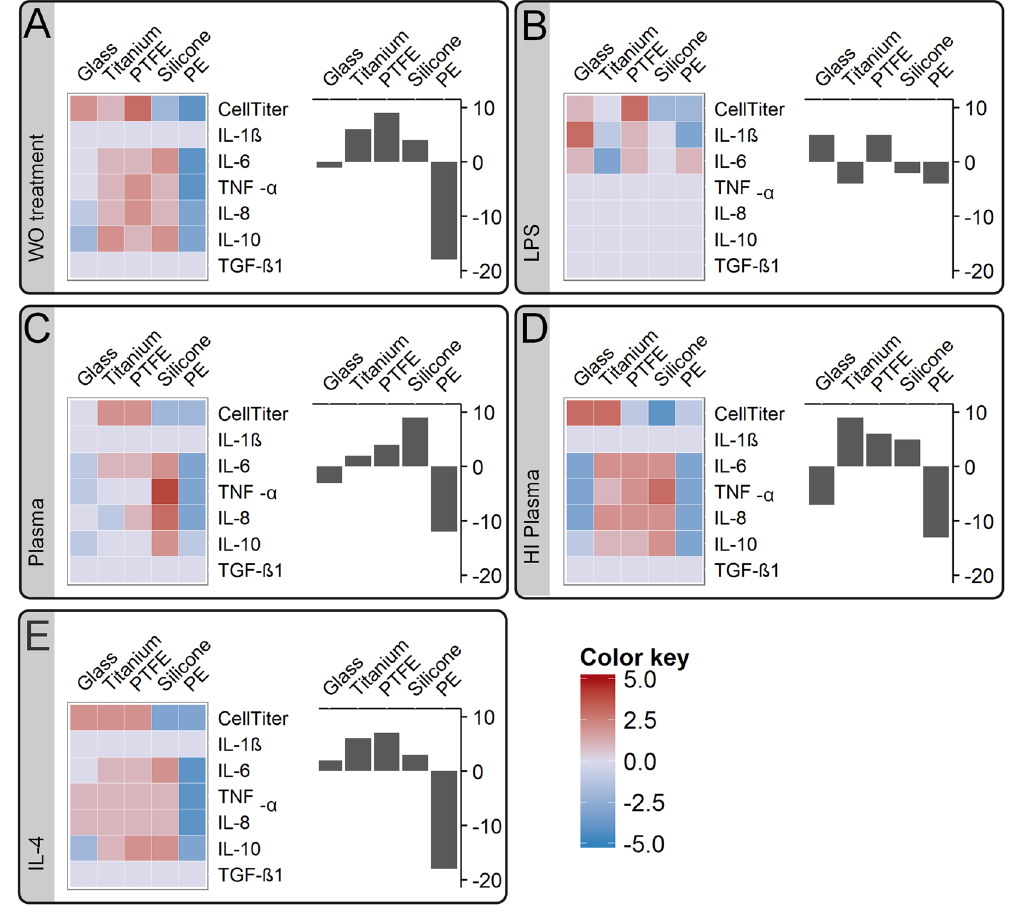
Figure 8. A significance profile of each material in comparison to all other tested materials was translated to a material scoring model. The obtained significance score values were translated into a color map in range of blue for minus values to red for positive values (left graph). Thereby, this scoring model visualized differences between the test conditions and finally allowed the evaluation of each specific readout factor respective to its predictive power. Finally for each material, the material ranking model summarized all readout-dependent scores in a bar plot (right graph). By comparing the literature-based biomaterial ranking to the obtained material rankings, a validation of each test condition for its accuracy to predict a fibrotic progression was performed: ( A ) without (WO) treatment, ( B ) LPS stimulation, ( C ) native plasma and ( D ) heat-inactivated (HI) plasma treatment as well as ( E ) IL-4